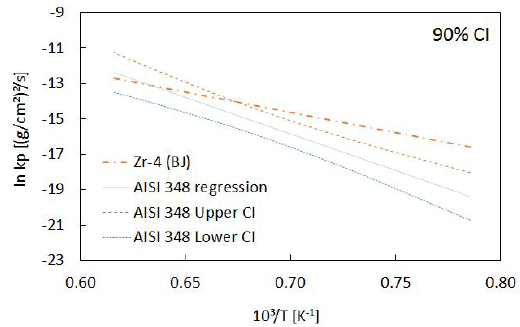
Figure 5. Arrhenius plot of AISI 348 proposed model and its 90% Confidence Intervals (CI) comparing to BJ 20 model for Zircaloy metal-water